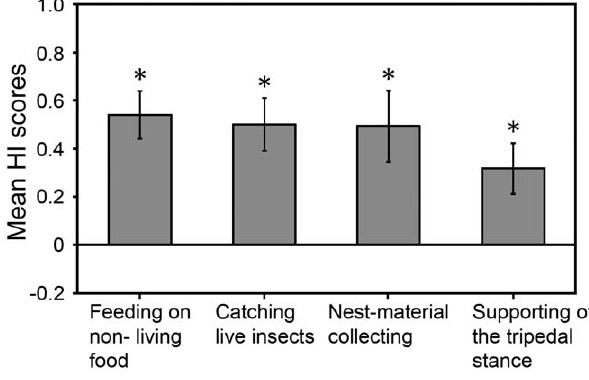
Figure 2. Direction of limb preferences for four types of unimanual behaviour investigated. Mean HI scores 6 SEM for feeding on non-living food ( n =12), catching live insects ( n =10), nest- material collecting ( n =11) and supporting of tripedal stance ( n =12) (positive values indicate left lateral bias, negative values indicate right lateral bias). Significant group-level preference of the left forelimb was revealed in all types of behaviour. * p , 0.05.